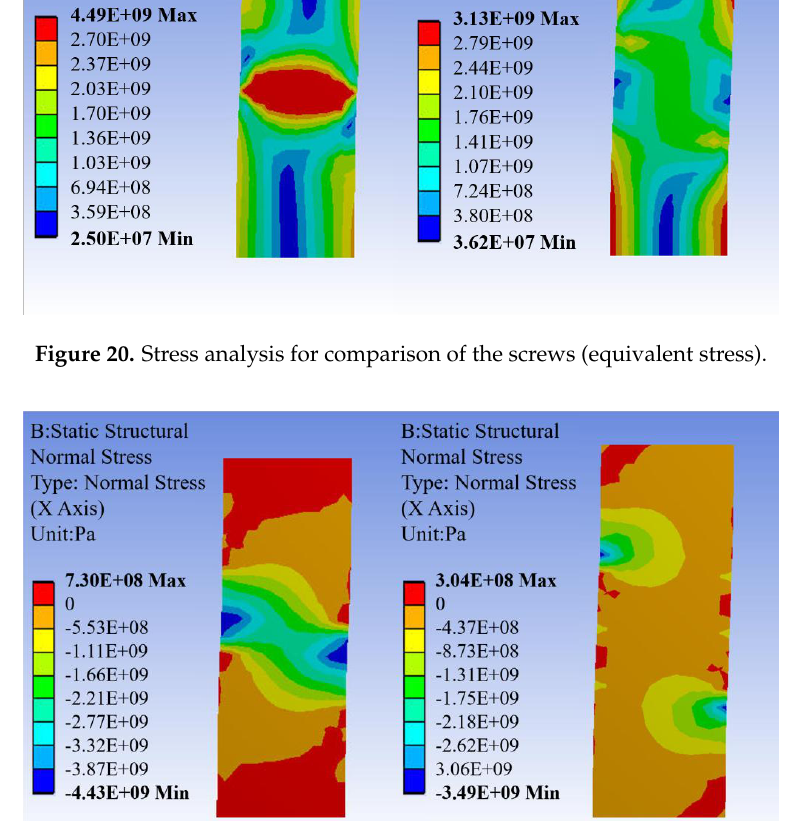
Figure 23. Stress analysis for comparison of the triangular hinge and simple straight hinge (maximum shear stress). Different types of stress are compared to verify that the triangular hinge is more structurally reliable for the truss. As Figure 24 shows, highly concentrated stress is much less for the triangular hinge, which results from the evenly distributed loading, so that the triangular hinge can withhold higher loading in applications.